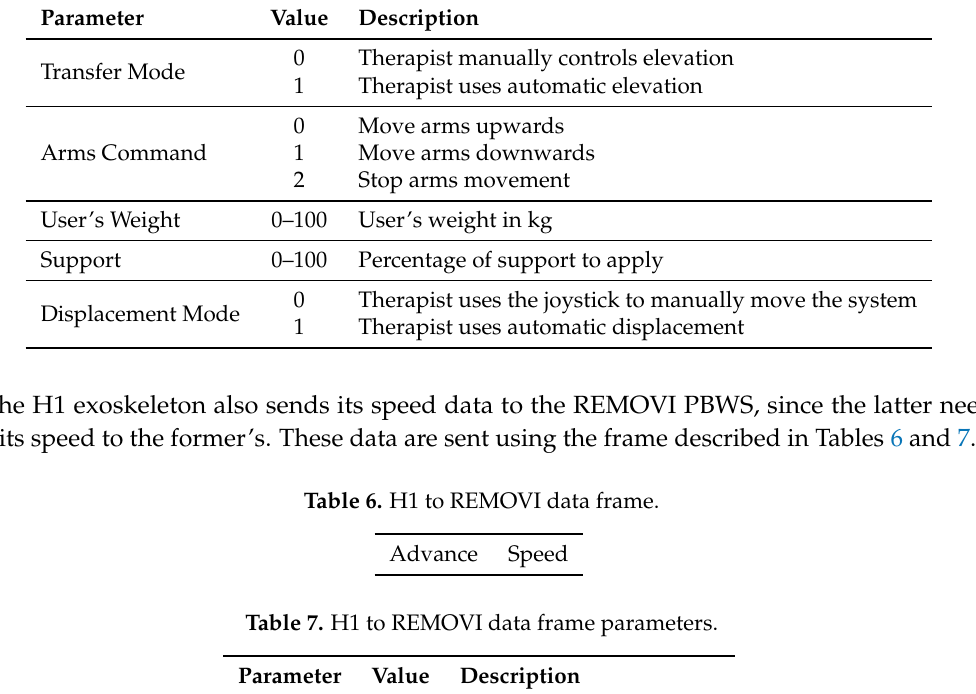
Table 7. H1 to REMOVI data frame parameters.